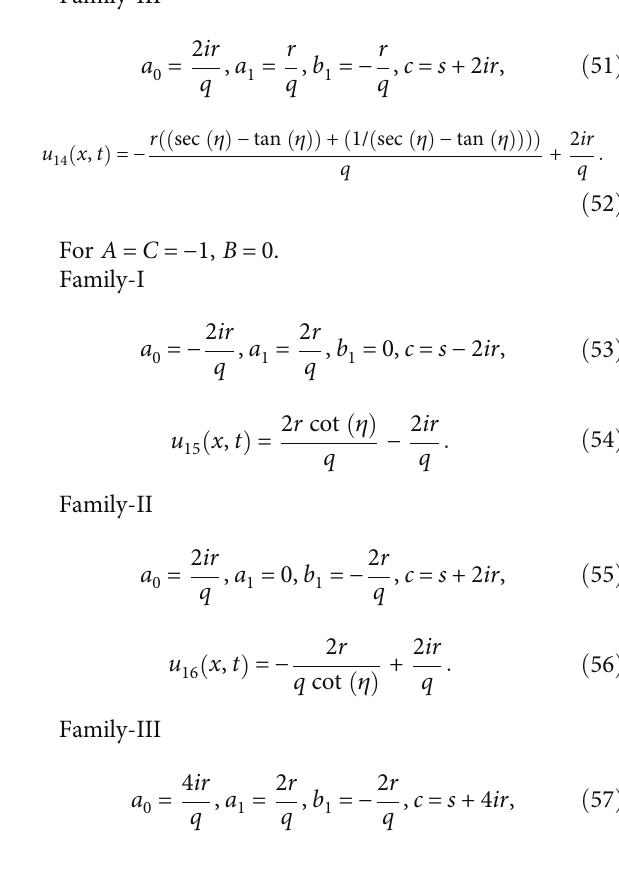
Figure 7: 2D and 3D graphics for trigonometric traveling wave solution (22) at f β = 0 : 5, r = 1, q = 1, λ 0 = 0 : 5, λ 1 = 0 : 5, C 1 = 0, C 2 = 1, c = 1 g :